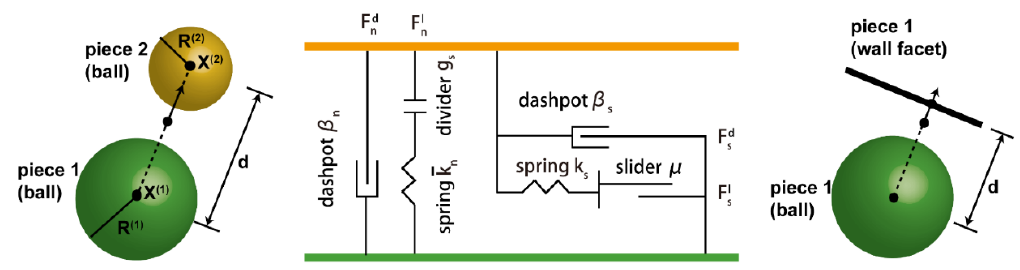
Figure 4. Illustration of the linear contact model and locations of contact planes for two fundamental contact types.